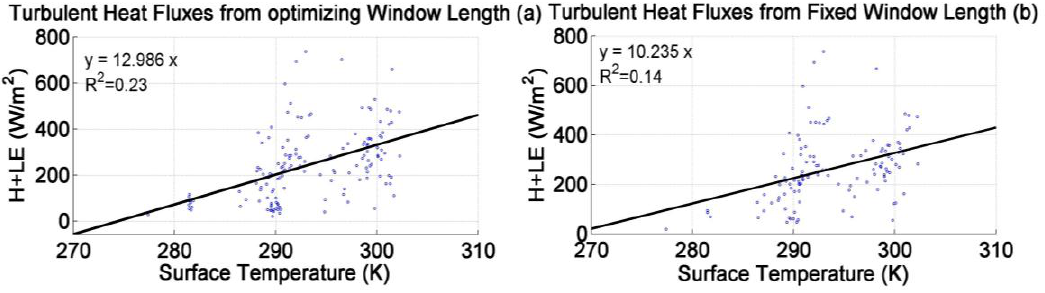
Figure 11. The relationship between the surface temperature (K) and the turbulent heat flux (sum of H and LE) based on optimizing ( a ) and fixed ( b ) window length.